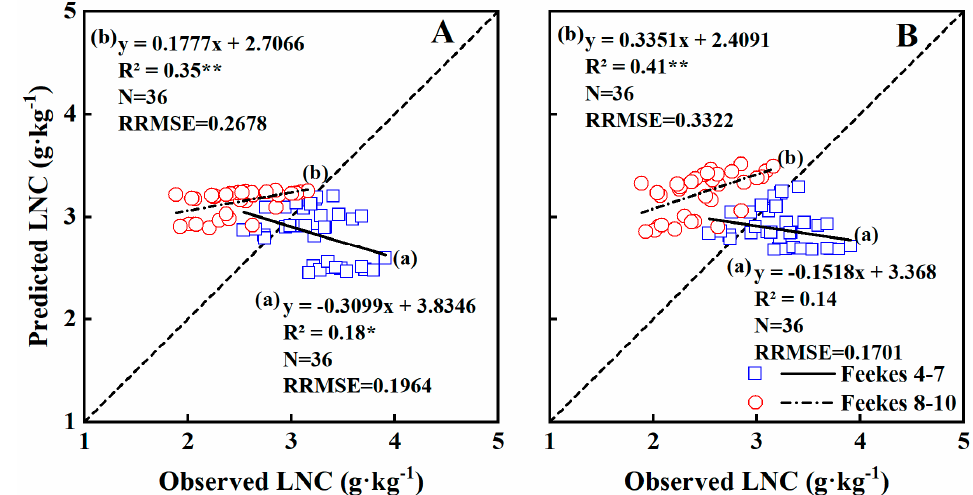
Figure 7. The relationships between observed and predicted LNC values of wheat varieties based on NDVI ( A ) and RVI ( B ) models in the Experiment 4 during vegetation growth period. The dotted line is inclined at 45° to the axes.